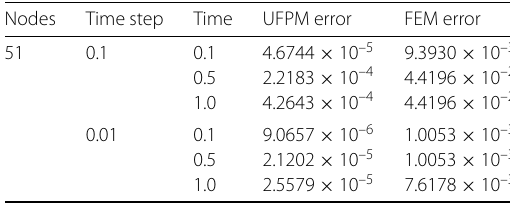
Table 5 Comparison of calculation results of UFPM and FEM